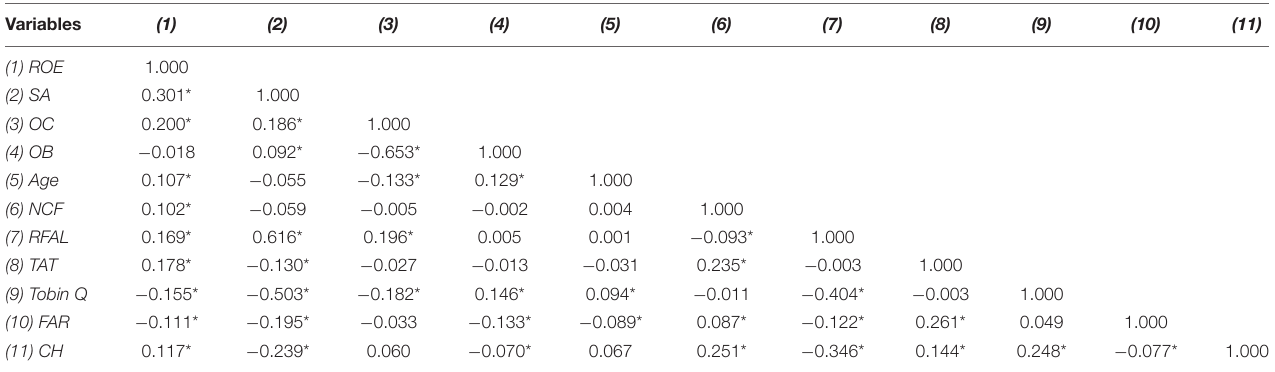
TABLE 4 | Correlation results of variables.